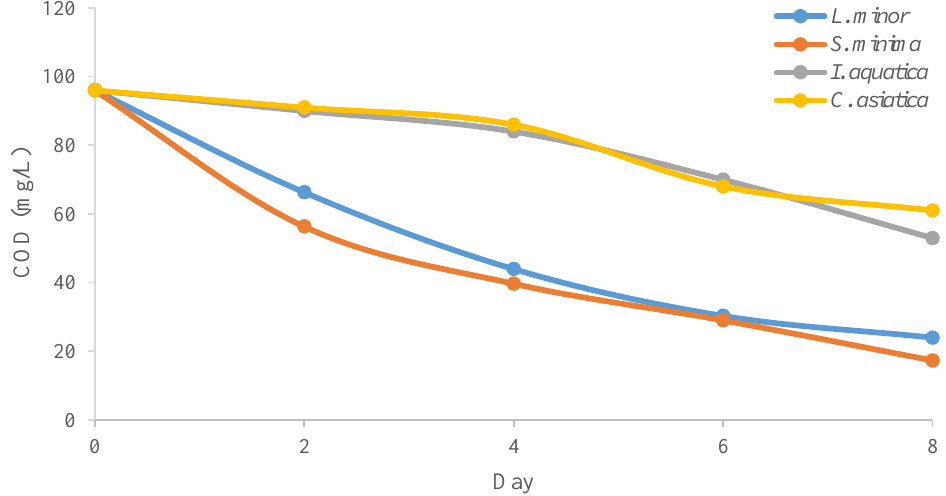
Figure 5. The average COD reading by the phytoremediation method using Lemna minor , Salvinia minima , Ipomoea aquatica and Centella asiatica .